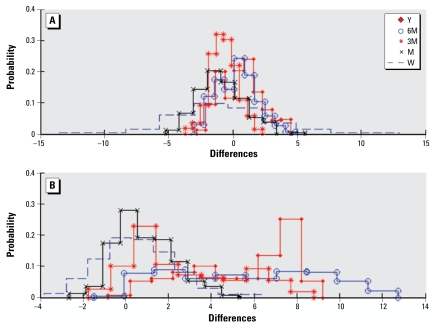
Abbreviations: M, 1 month; 3M, 3 months; 6M, 6 months; W, 1 week; Y, 1 year. Distribution of differences between the UM1 and UM2 exposure estimates for PM10 (A) and ozone (B) at multiple time scales.